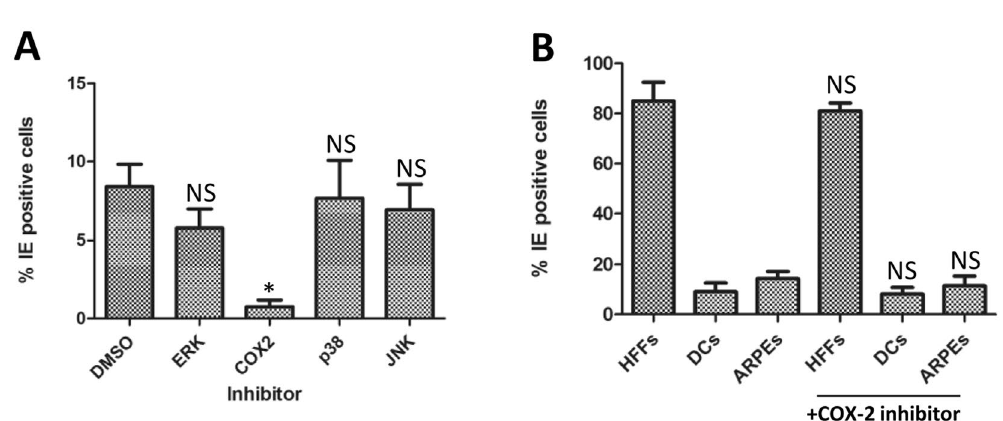
Figure 8. A COX-2 inhibitor antagonises LPS mediated permissiveness of monocytes. ( A ) Monocytes were incubated with control (DMSO), or inhibitors of ERK, COX2, p38 or JNK for 4 hours prior to addition of LPS (500 ng/ml). After 24 hours, cells were then infected with Merlin and stained for IE protein expression 24hpi. Nuclei were counter-stained with DAPI and infection rate calculated n = 3. ** p < 0.01; NS = non-significant difference when compared to infection of DMSO solvent control. ( B ) HFFs, monocyte derived dendritic cells (DCs) or epithelial cells (ARPE) were pre-treated with DMSO or a COX-2 inhibitor for 4 hours then infected with Merlin and stained for IE protein expression 24hpi. Nuclei were counter-stained with DAPI and infection rate calculated n = 3. NS = non-significant difference when comparing rate of infection of each cell type plus and minus